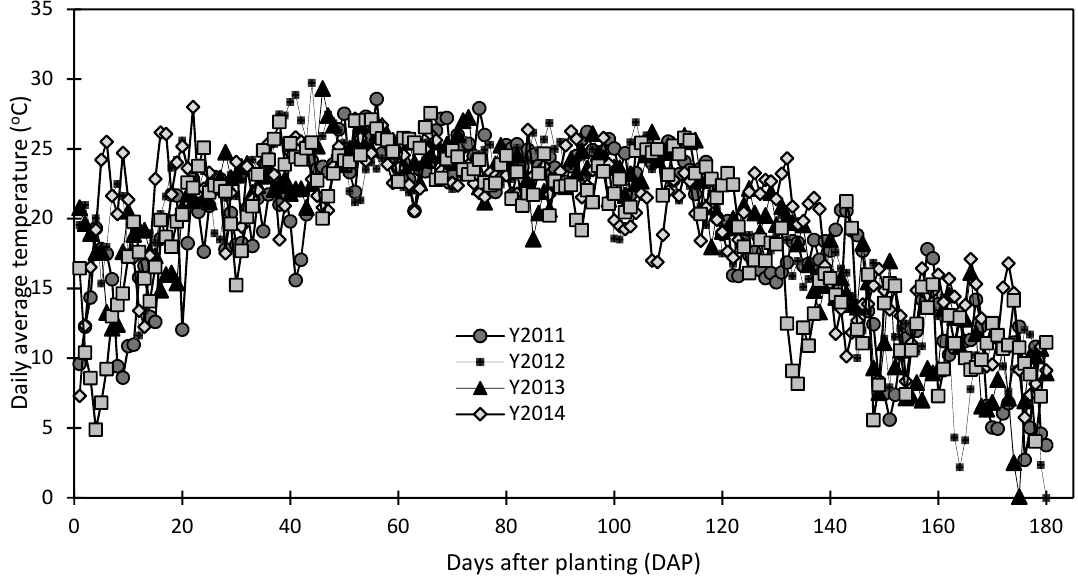
Figure 1. Trends in the daily average temperature for maize growing seasons 2011, 2012, 2013, 2014 and 2017, Agricultural Science Center at Farmington, NM.